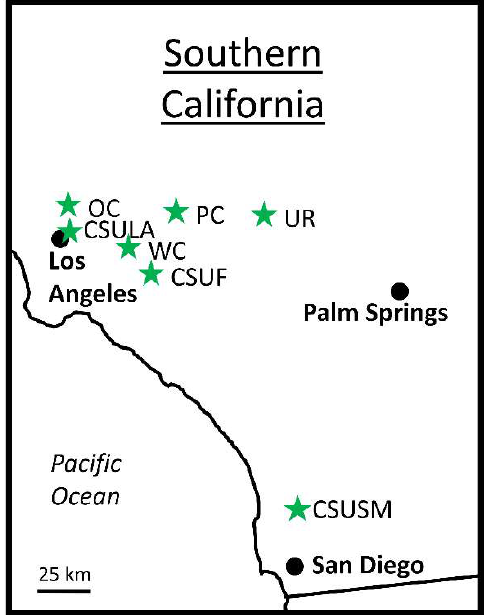
Figure 1. Map of the of the seven college campuses in southern California. At each campus, decomposition and nitrogen mineralization was examined in five landcover types. For a description of site characteristics for the seven colleges, see Table A1.